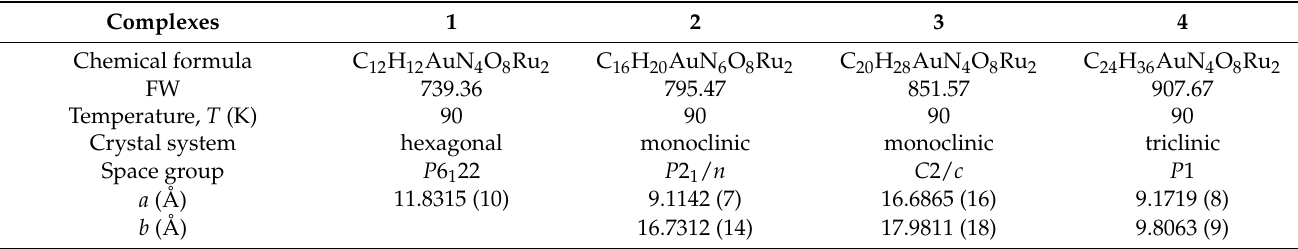
Table 1. Crystallographic data and structure refinement of 1 – 4